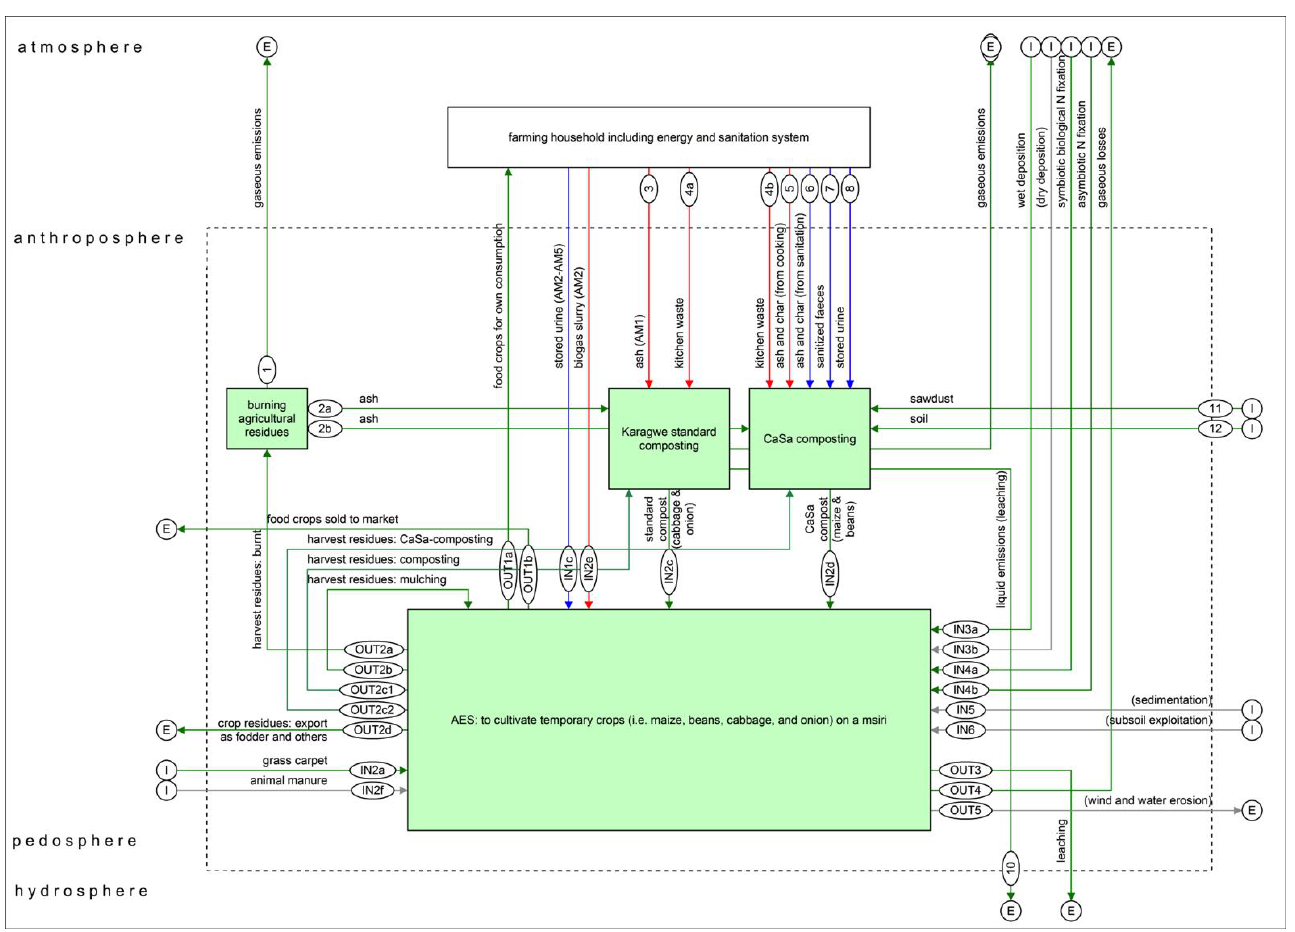
Figure 1. The integrated farming system analyzed comprises the farming household (white) and the agro-ecosystem (AES; green). Processes are indicated with boxes, material flows with arrows; the dotted line represents the system boundaries. Material flows in green were part of the present work; red and blue flows/arrows were part of [41]; grey flows/arrows were not considered in the system analysis. AM: Abbreviation part of the scenarios indicating the agroecosystem of a msiri.